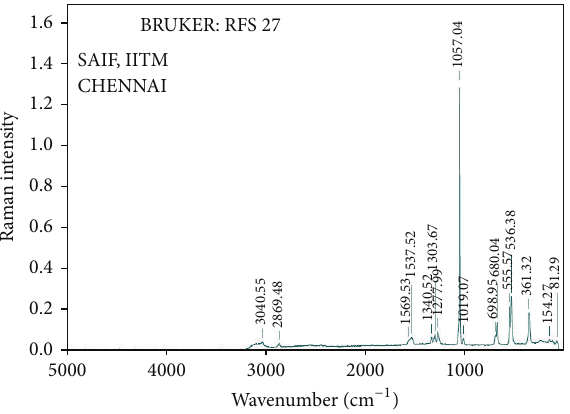
Figure 2: FT-IR spectrum.